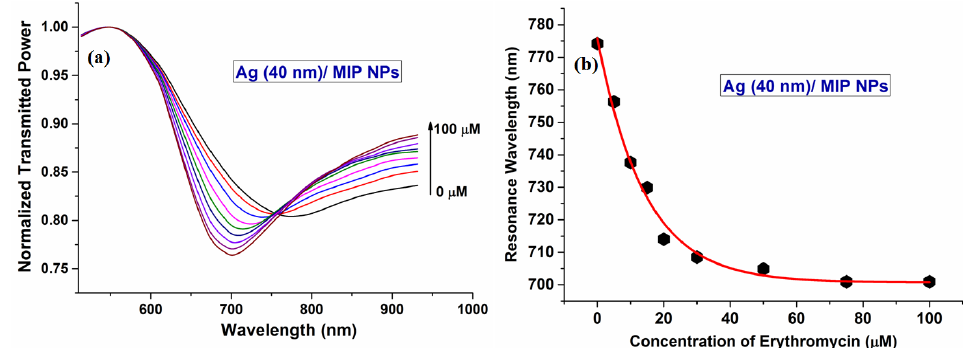
Figure 17. ( a ) SPR spectra and ( b ) variation in resonance wavelength with changing erythromycin concentration from 0–100 µm for SPR and molecularly imprinted nanoparticle-based ERY sensor. Reprinted with permission from [179]. Copyright 2016 The Optical Society (OSA).